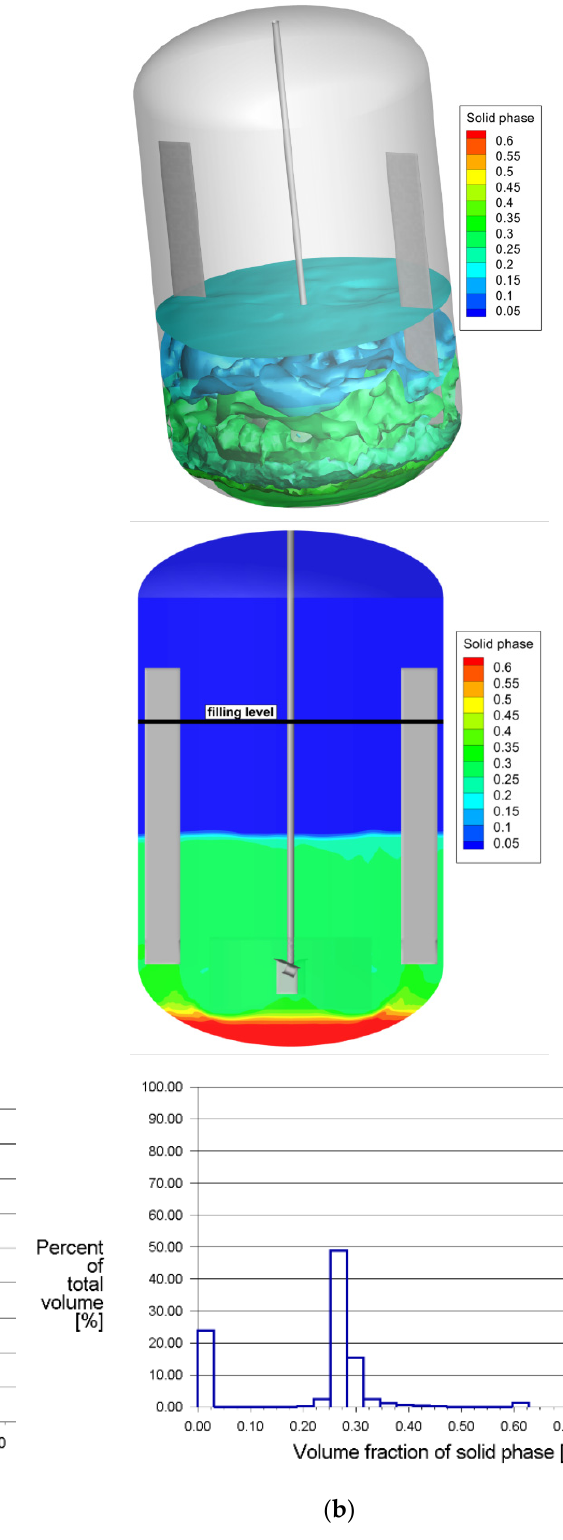
Figure 4. Final state of the volume fraction distribution of the solid phase: ( a ) flow started from the solid phase fully sedimented; ( b ) flow started from the solid phase dispersed in the entire volume of liquid.